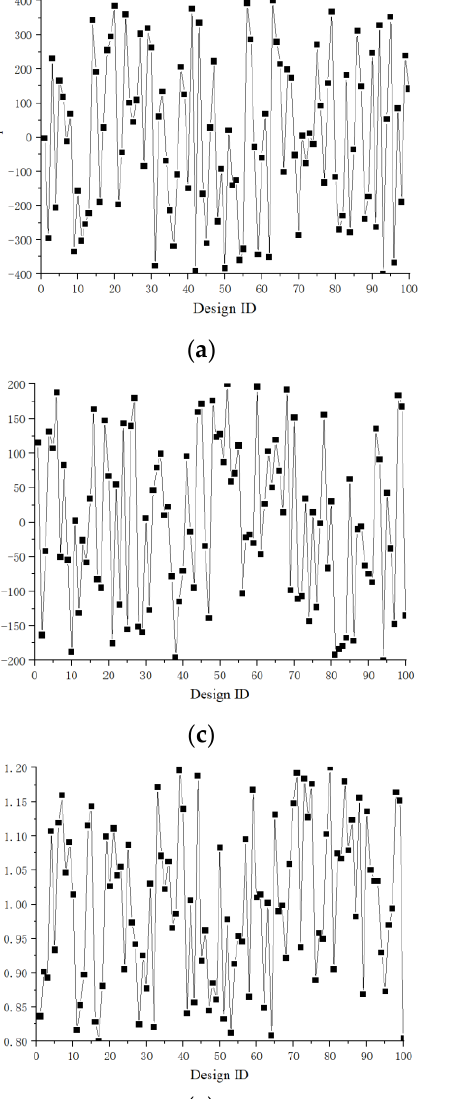
( b ) Figure 6. Error between predicted value and actual value of output variables: ( a ) Percentage of aerodynamic resistance, ( b ) Difference of dipole noise source. In the optimization calculation, the initial sampling points of the NSGA- Ⅱ algorithm are set to be 20, and 50 generations of genetic calculation are performed. Thus, the opti- mization is completed after completion of 1000 designs. Figure 7 depicts histories of de- sign variables during optimization, and the pattern “ ★ ” in the figure indicates the Pareto optimal solution. As plotted in Figure 7, each optimization design variable shows a con- vergence trend through the sampling of the optimization algorithm. The NSGA- Ⅱ algo- rithm will find the Pareto optimal design point that minimizes the objective value through